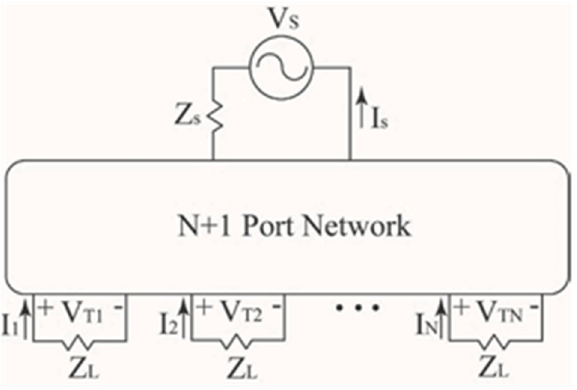
Figure 3. N -port network illustration of conformal array with a signal of interest at angle 𝜃 (cid:3020)(cid:3016)(cid:3010) or 𝜃 (cid:3020)(cid:3015)(cid:3016)(cid:3010) (cid:3289) . or θ SNOI n